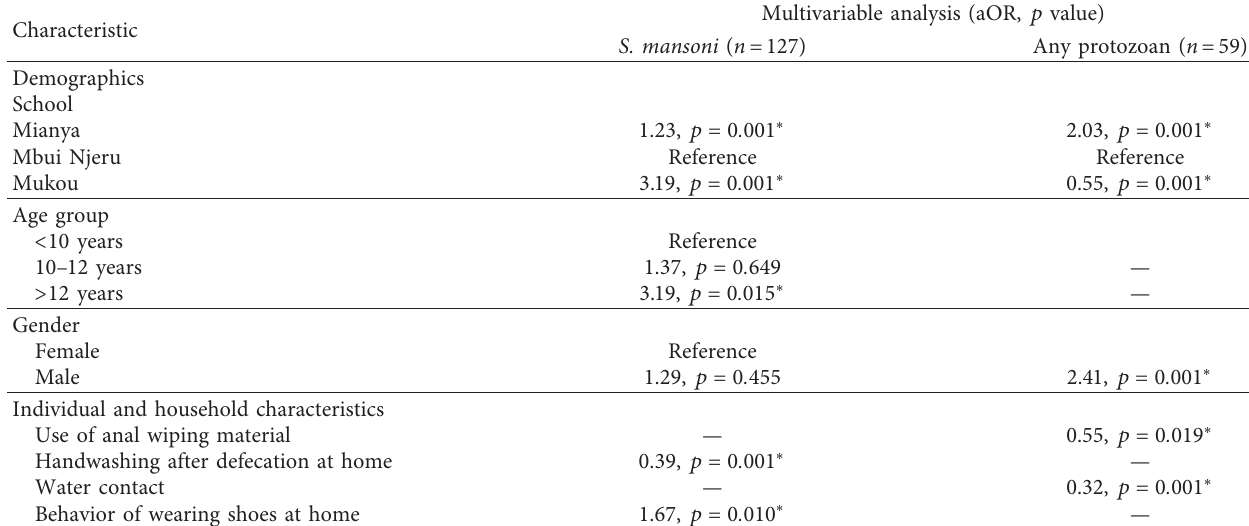
Table 3: Multivariable analysis of risk factors of S. mansoni and any intestinal protozoa infection.